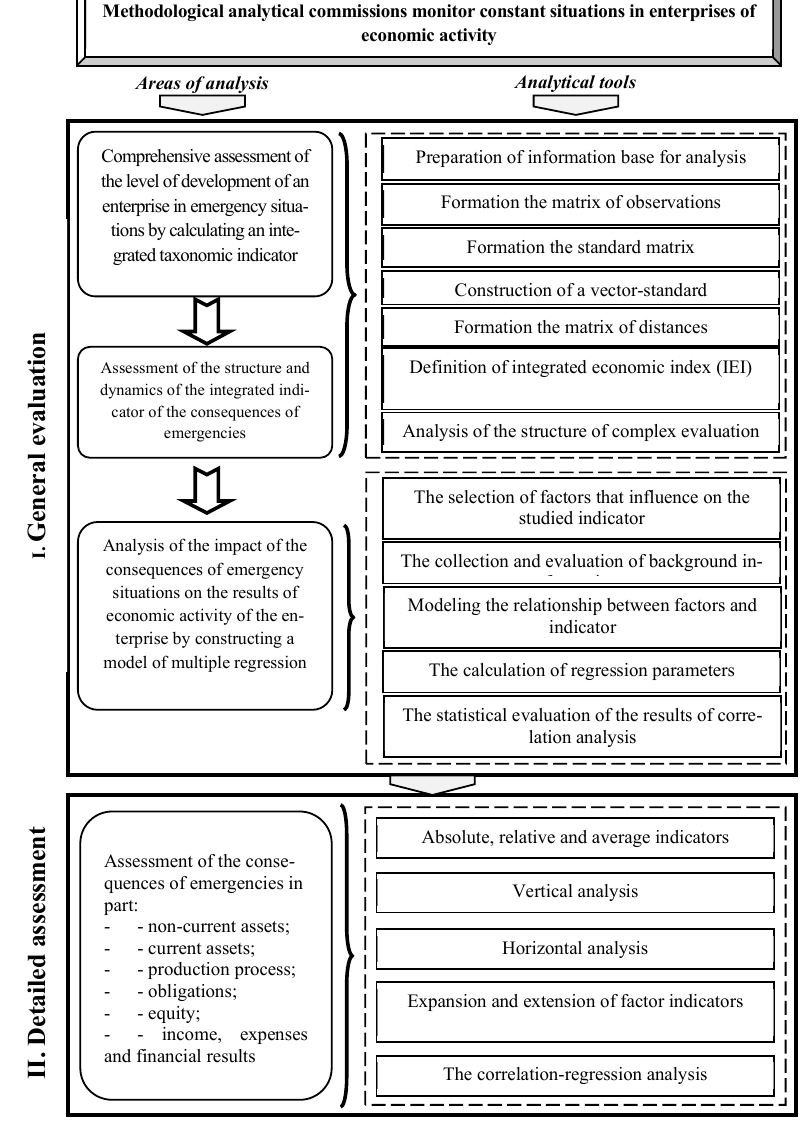
Fig. 1 . The comprehensive method for analytical assessment of the impact of emergencies on the indicators of the